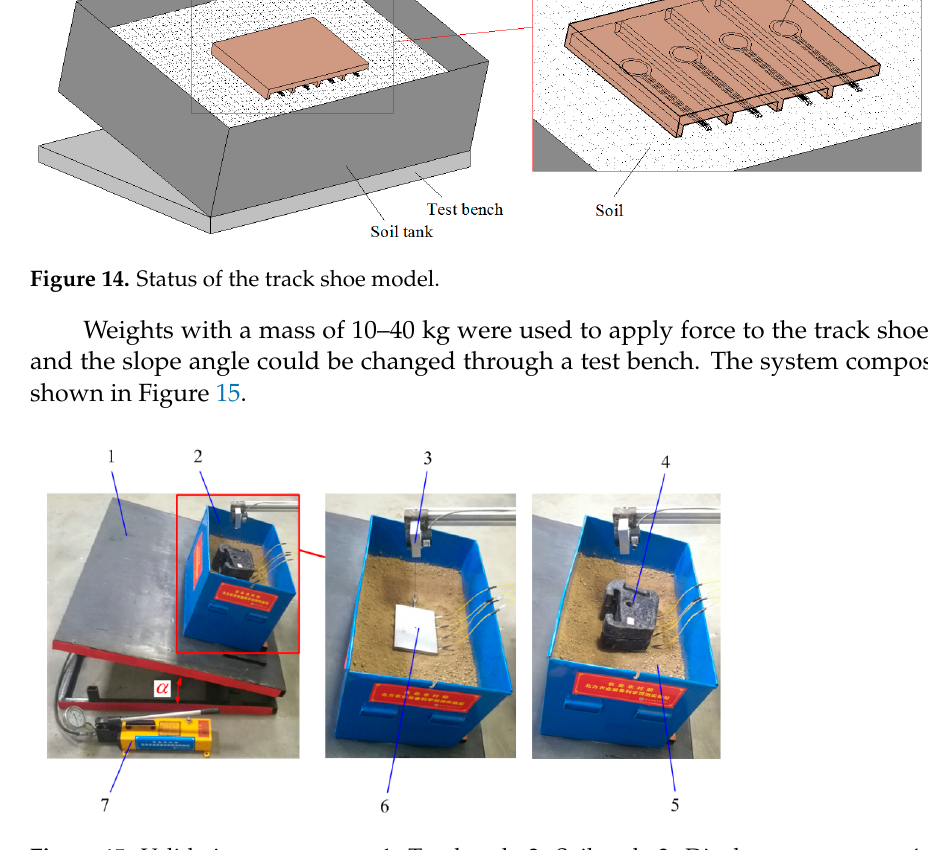
Figure 13. Schematic diagram of validation test principle.